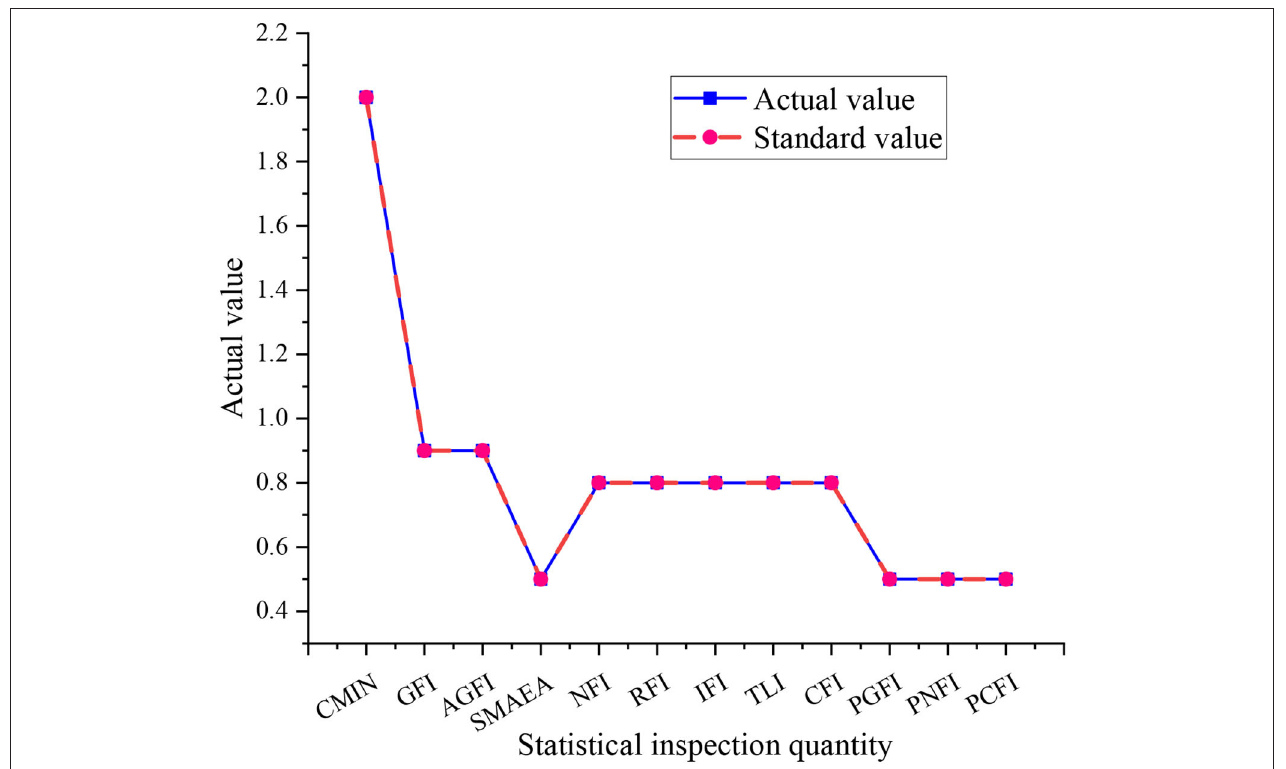
FIGURE 5 | Fitting results of the optimized